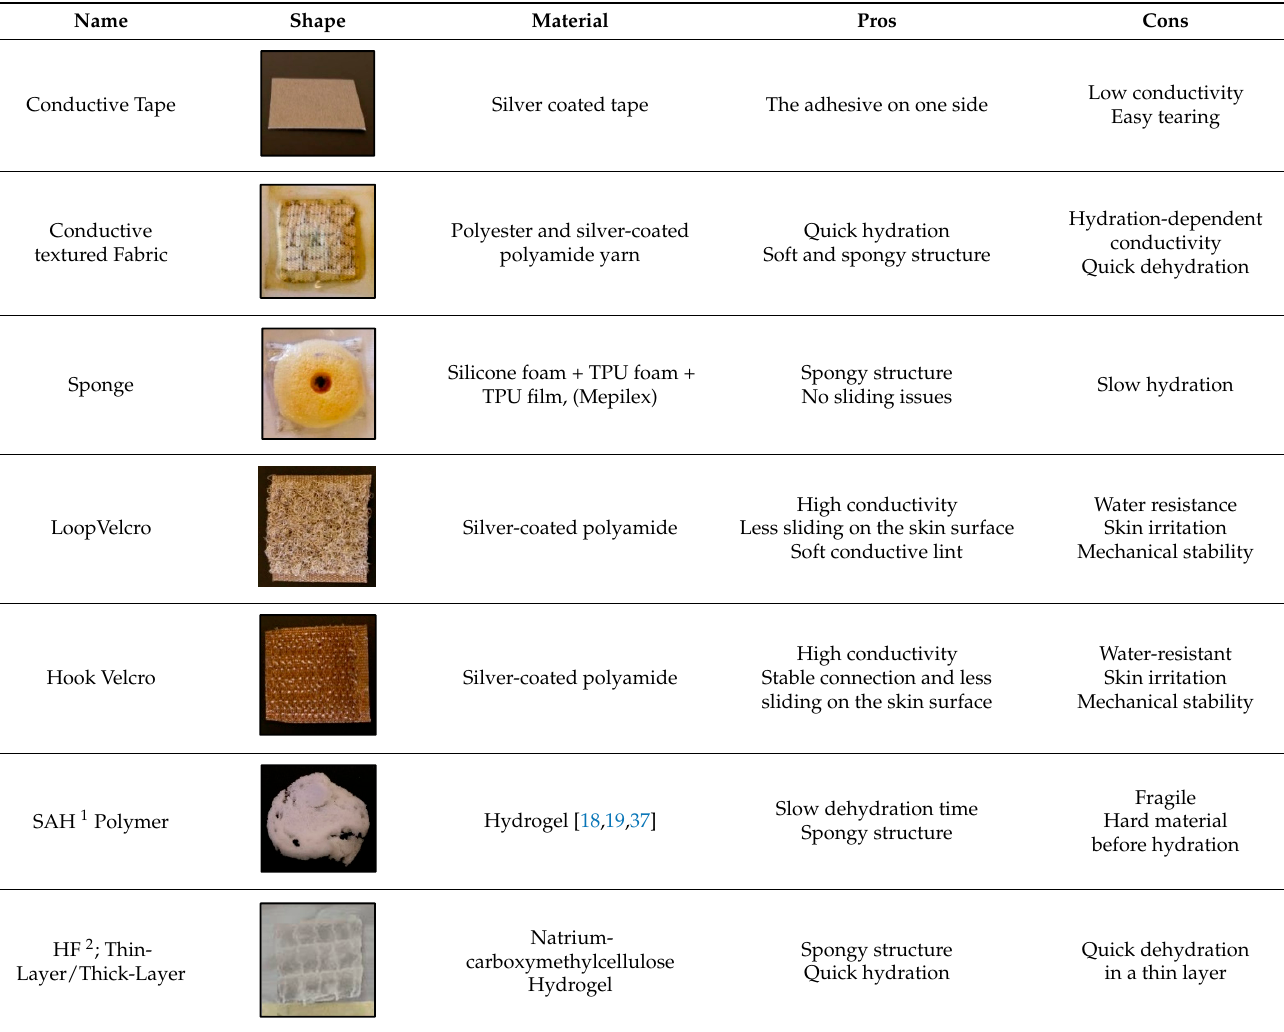
Table 2. Name, pros, and cons of the skin ‐ electrode interface materials.